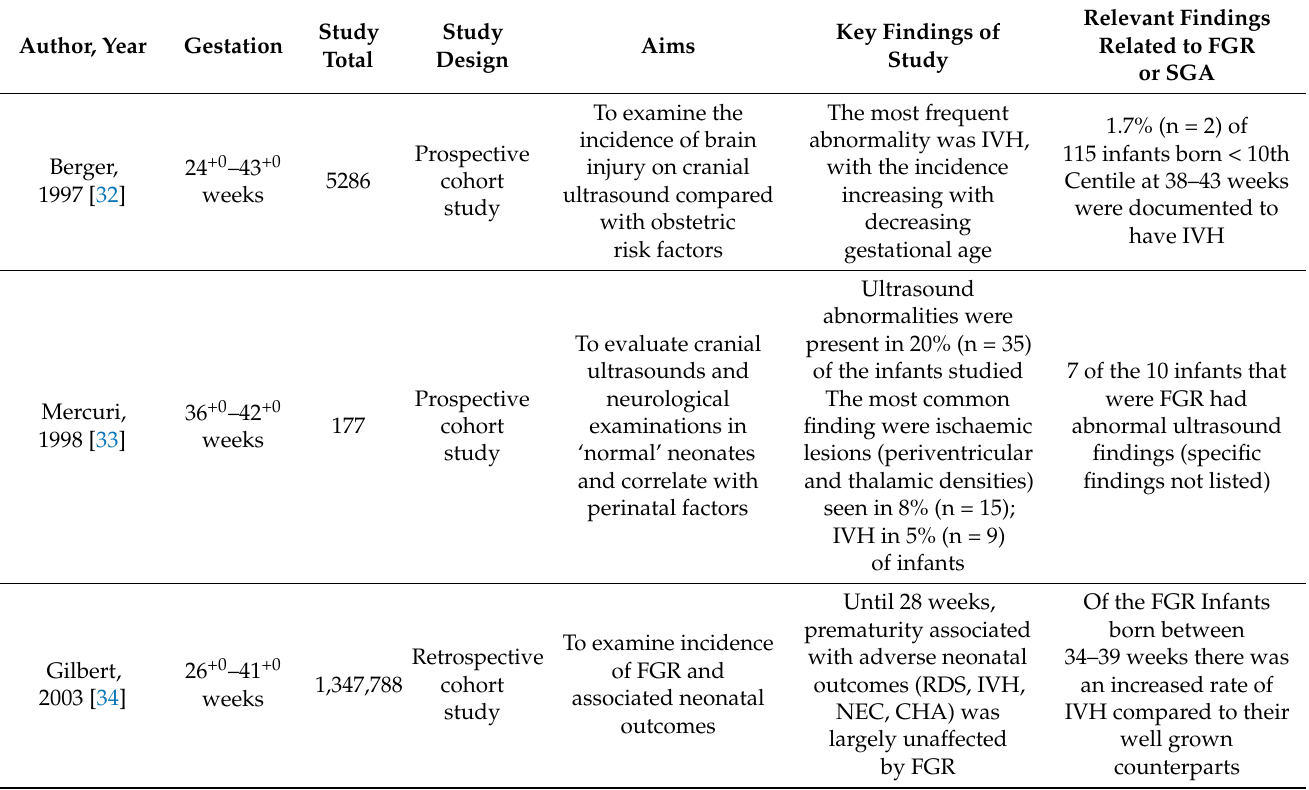
Table 6. Studies including cranial ultrasonography in late preterm and term SGA/FGR